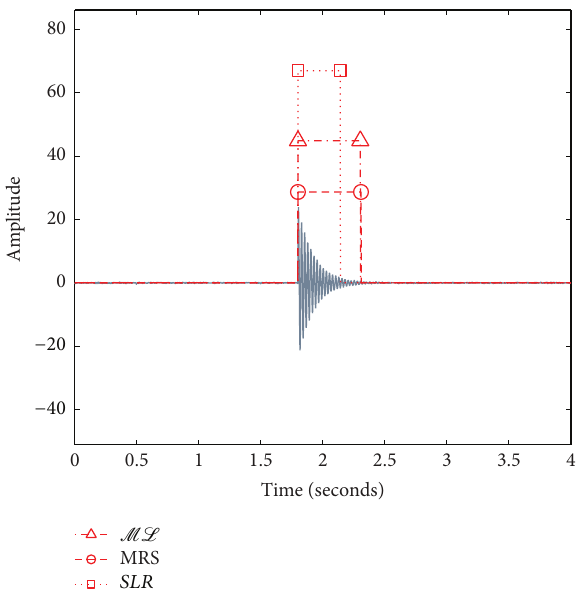
Figure 6: The comparison of segments produced by different methods applied to the simulated multievents